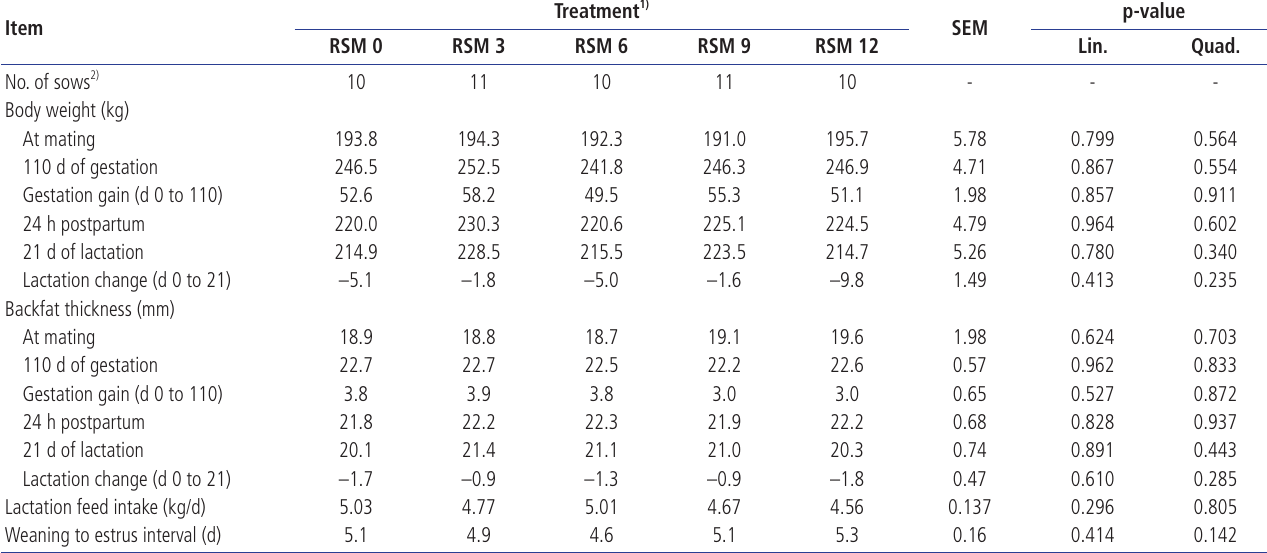
Table 4. Effect of rapeseed meal (RSM) supplementation levels in gestation diets on body weight, backfat thickness, lactation feed intake and weaning to estrus interval of gestation and lactation